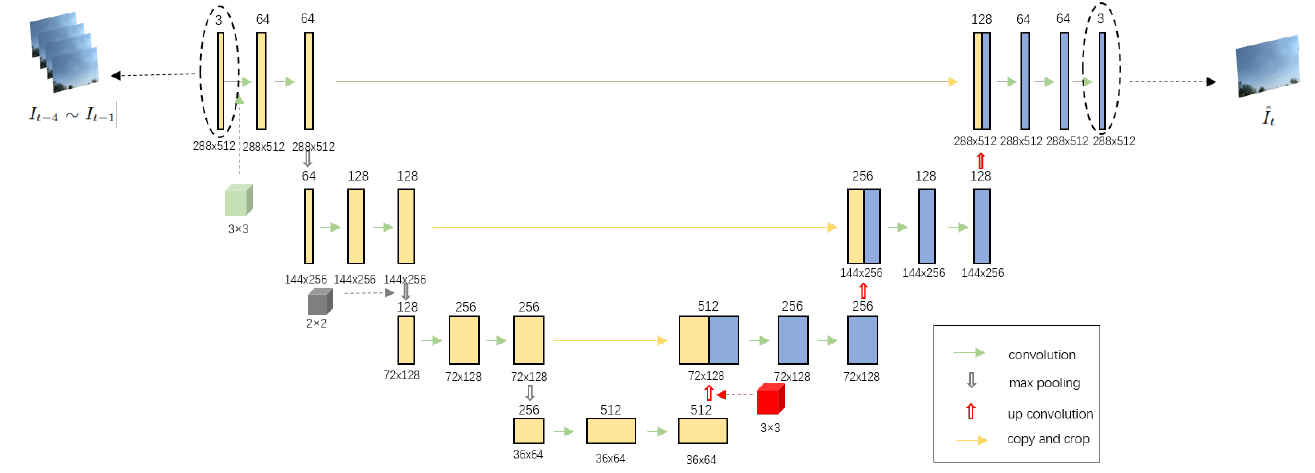
Figure 2. Structure of the modified U-Net network for generating predicted future